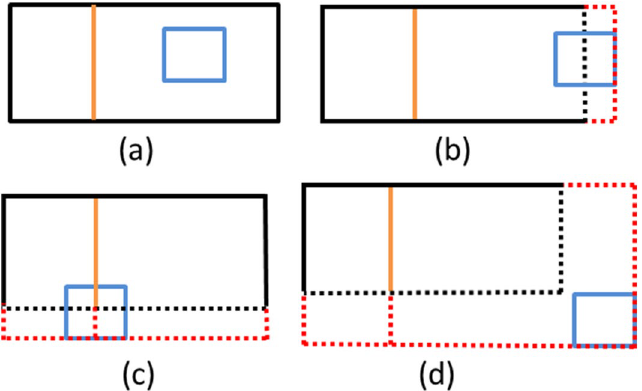
Fig. 6 The instance of updation after inserting new MBH in 2D space. A Upadation when the new MBH is included in only one node in SKDTree, B Upadation when the new MBH intersects only one node in SKDTree, C Upadation when the new MBH intersects more than one node in SKDTree, D Upadation when the new MBH separates from all the nodes in SKDTree. Note: The black rectangle represents the range of SKDTree root. The blue rectangle represents the cluster cell to be inserted. The orange solid line represents the original split hyperplane. The black dashed line represents the updated range. The red dashed line represents the new